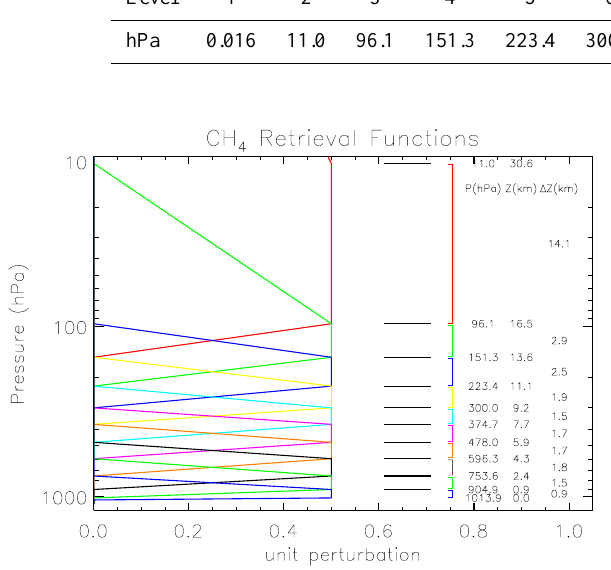
Fig. 3. Example of the first guess profiles in latitudes of 60 ◦ S, 30 ◦ S, 0, 30 ◦ N and 60 ◦ N.